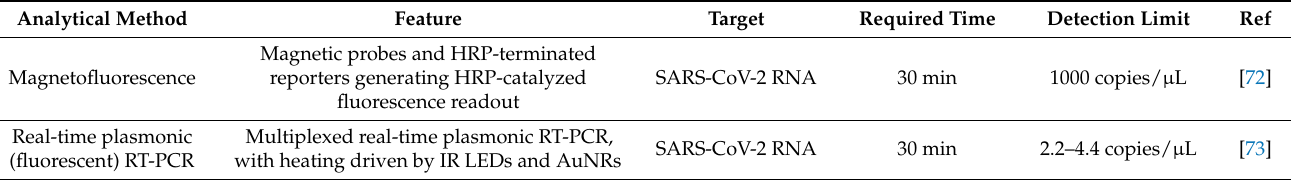
Table 3. Comparison of fluorescent-based plasmonic nanobiosensors for viral RNA detection. Analytical